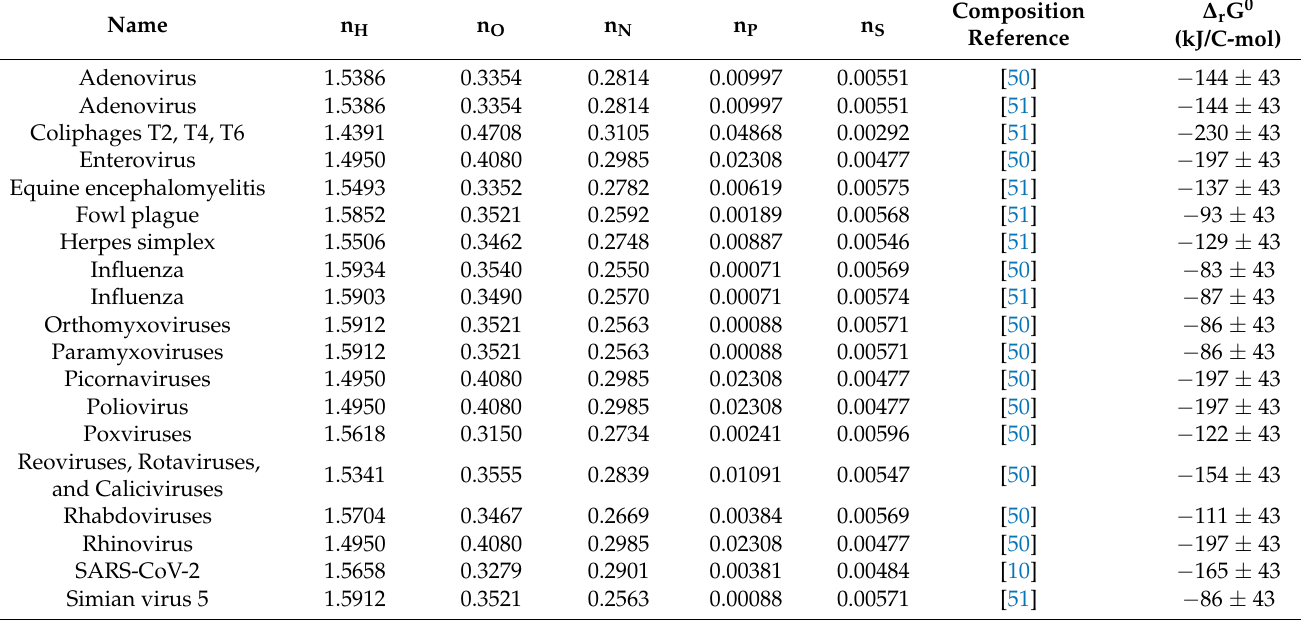
Table 2. Elemental compositions and Gibbs energies of growth of viruses. The elemental composition refers to empirical formulas of the form CH nH O nO N nN P nP S nS . The elemental compositions of the viruses were calculated as described in Section 2.2, starting from data in the “Composition reference” column. The viruses marked with an asterisk are enveloped viruses. For enveloped viruses, lipids were not included in the calculations, since they are taken from the host cell during budding and not synthesized at the ribosomes